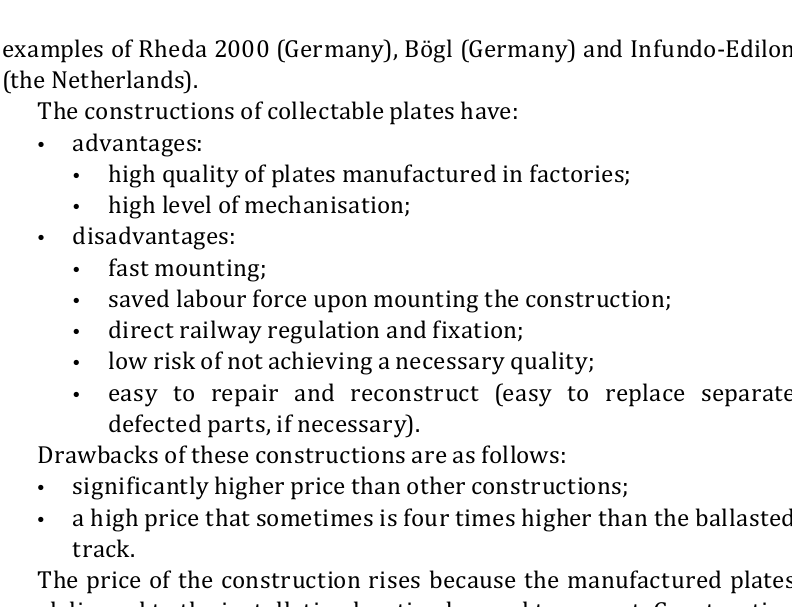
Figure 3. BOGL slab track